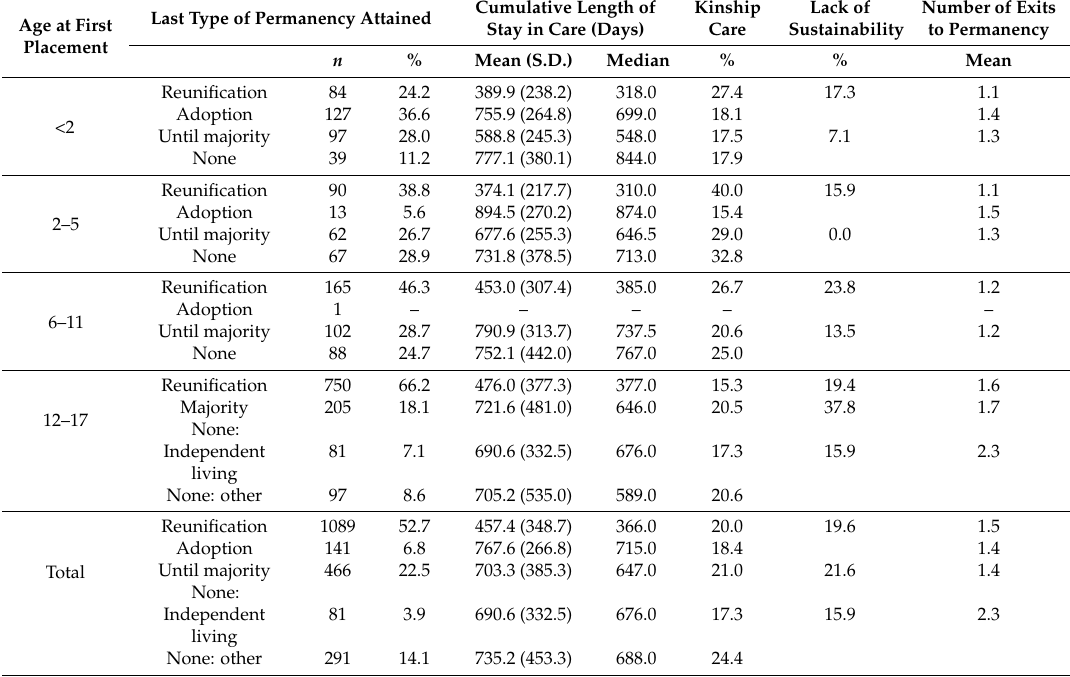
Table 7. Type of permanency and cumulative time in care according to the age of the child at first placement, among children from cohort Post2 who are placed at least once in non-kinship and whose case have been brought to court ( n =